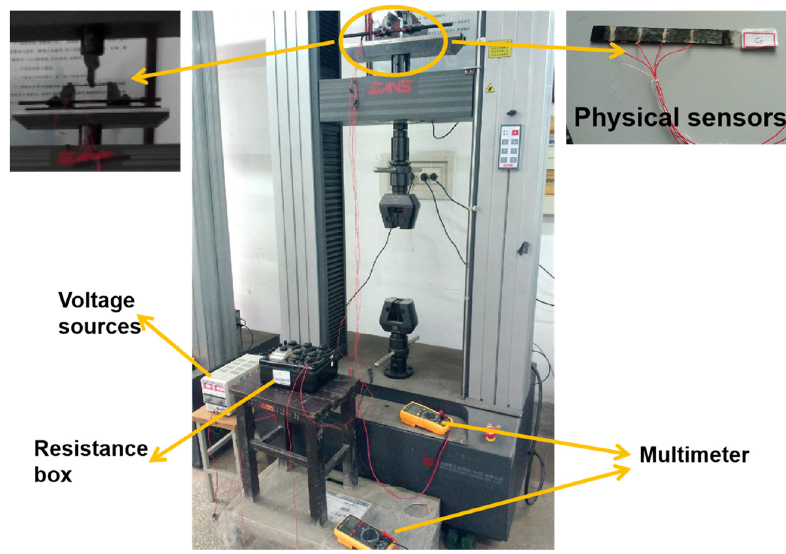
Figure 3: Piezoresistive testing of CNTFS under cyclic loading with four - electrode method by a universal testing